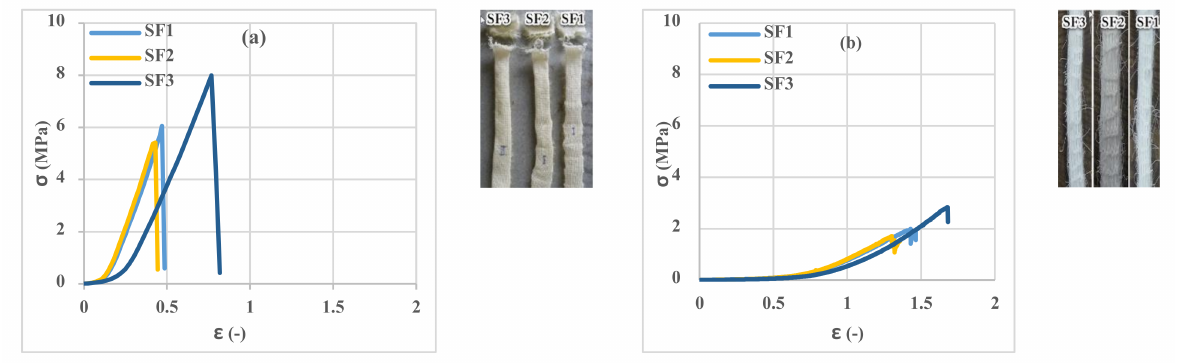
Figure 6. Tensile stress–strain curves of 3D spacer fabrics: ( a ) weft direction and ( b ) warp